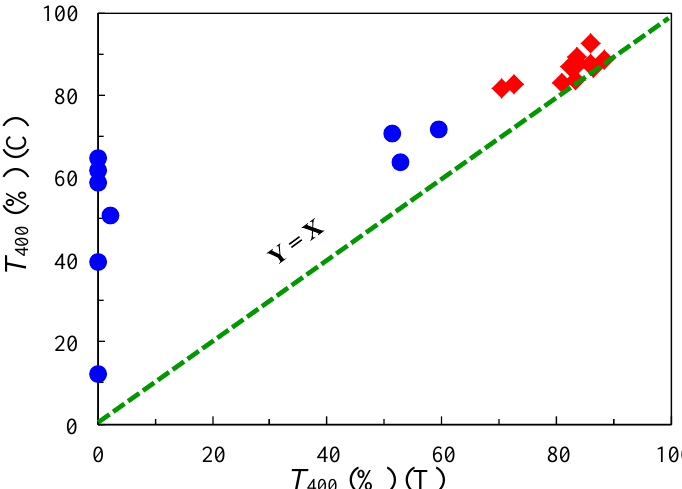
Figure 3. Effect of imidization method [chemical imidization (C) and thermal imidization (T)] on light transmittance at 400 nm ( T 400 ). (●) PEsIs derived from substituted TA-HQ and TFMB and ( ♦ ) H″-PMDA-based PIs. The dotted line denotes the relationship: Y = X . Reproduced with permission from Elsevier [21].